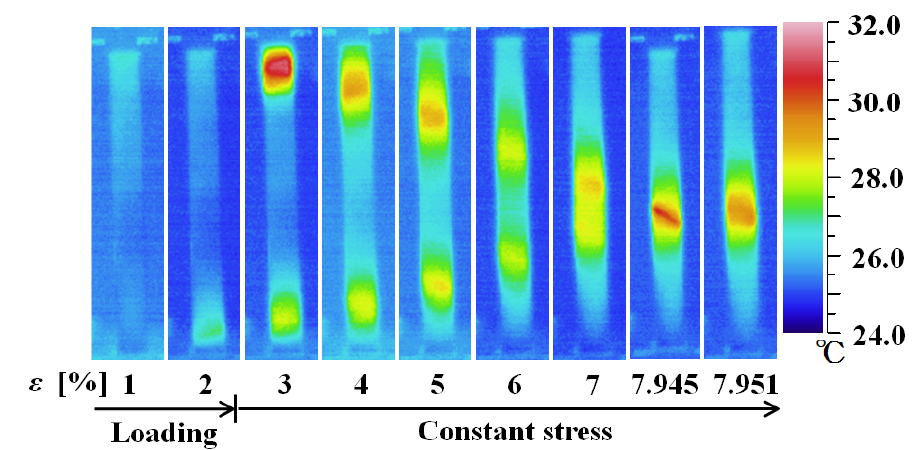
Figure 7. Thermograms of temperature distribution on the specimen surface under d σ /d t = 0.5 MPa/s up to a strain ε of 2% followed by constant stress.